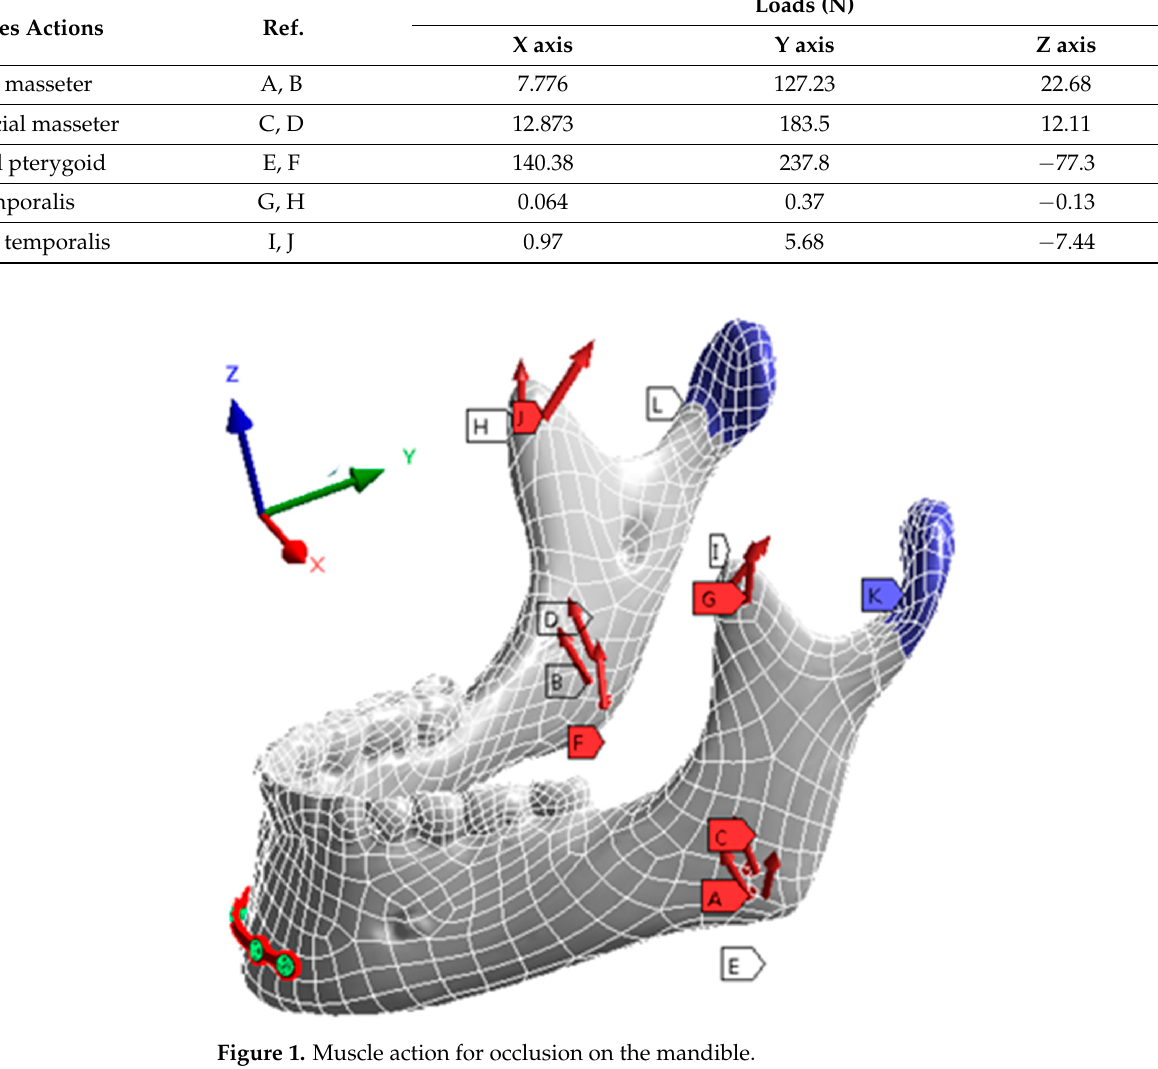
Figure 1. Muscle action for occlusion on the mandible. Table 2. Forces and acting direction of the major muscles applied onto the mandible for occlusion in the finite element analysis [28].